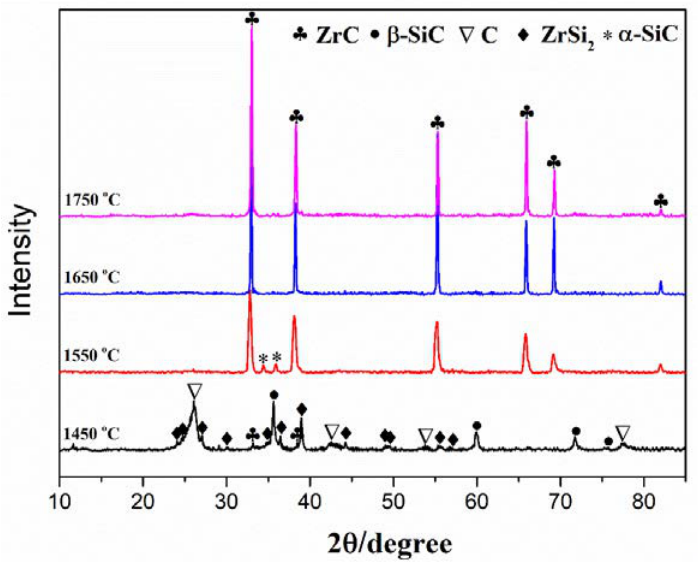
Figure 1. Surface XRD patterns of the ZrC–SiC inner layer with different temperatures.